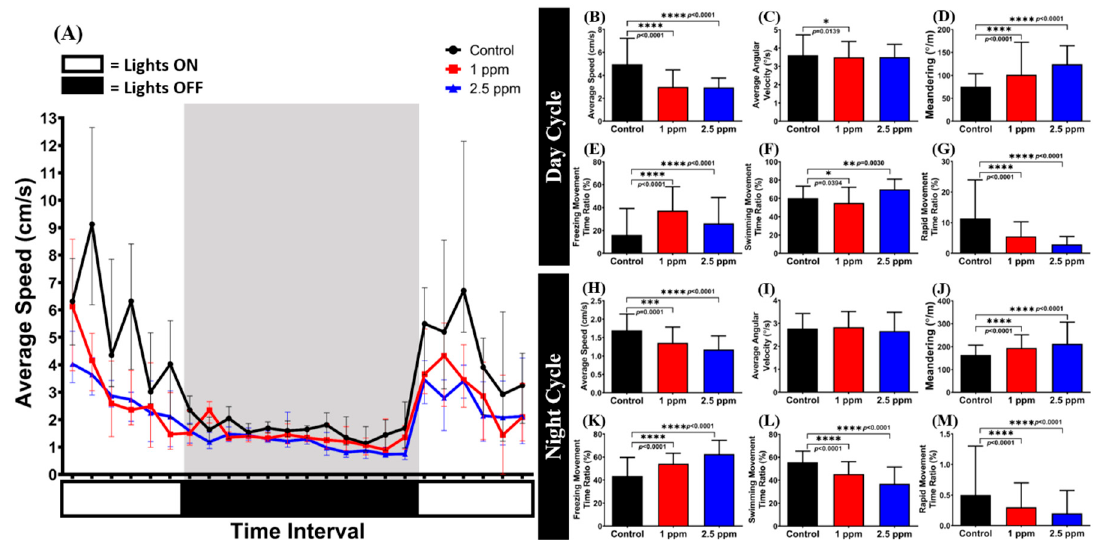
Figure 6. Evaluation of the circadian locomotor activity for control and chronic donepezil-exposed fish: ( A ) Circadian patterns of average speed; ( B ) average speed; ( C ) average angular velocity; ( D ) meandering; ( E ) freezing movement time ratio; ( F ) swimming movement time ratio; and ( G ) rapid movement ratio during the light cycle. ( H ) Average speed; ( I ) average angular velocity; ( J ) meandering; ( K ) freezing movement time ratio; ( L ) swimming movement time ratio; and ( M ) rapid movement ratio during the dark cycle. The data are expressed as the median with interquartile range and were analyzed using Kruskal–Wallis test followed by Dunn’s multiple comparisons test ( n control fish = 18; n donepezil-treated fish = 18; * p < 0.05, ** p < 0.01, *** p < 0.001, **** p < 0.0001).